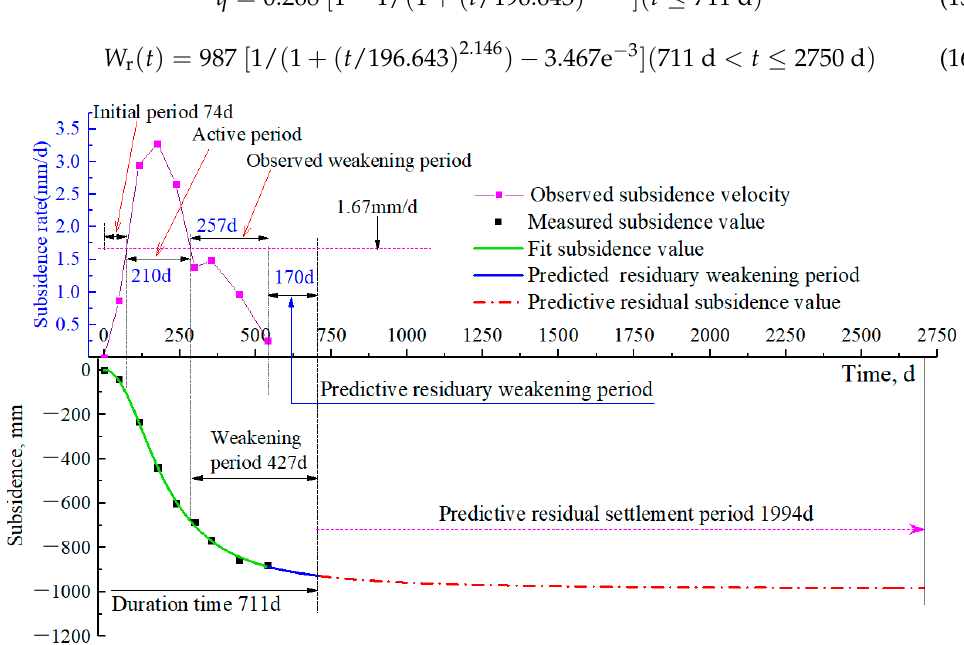
Figure 9. Predictive results for weakening period and residual subsidence period in terms of maxi- mum subsidence point.